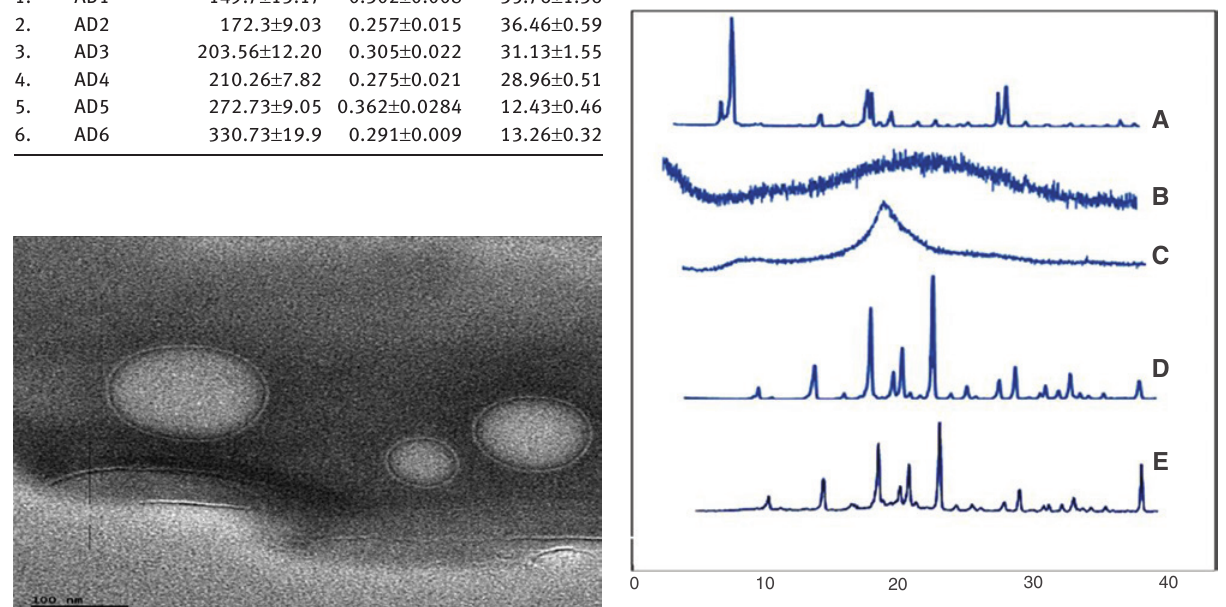
Figure 3: PXRD of (A) drug, (B) DS, (C) CS, (D) mannitol, and (E)